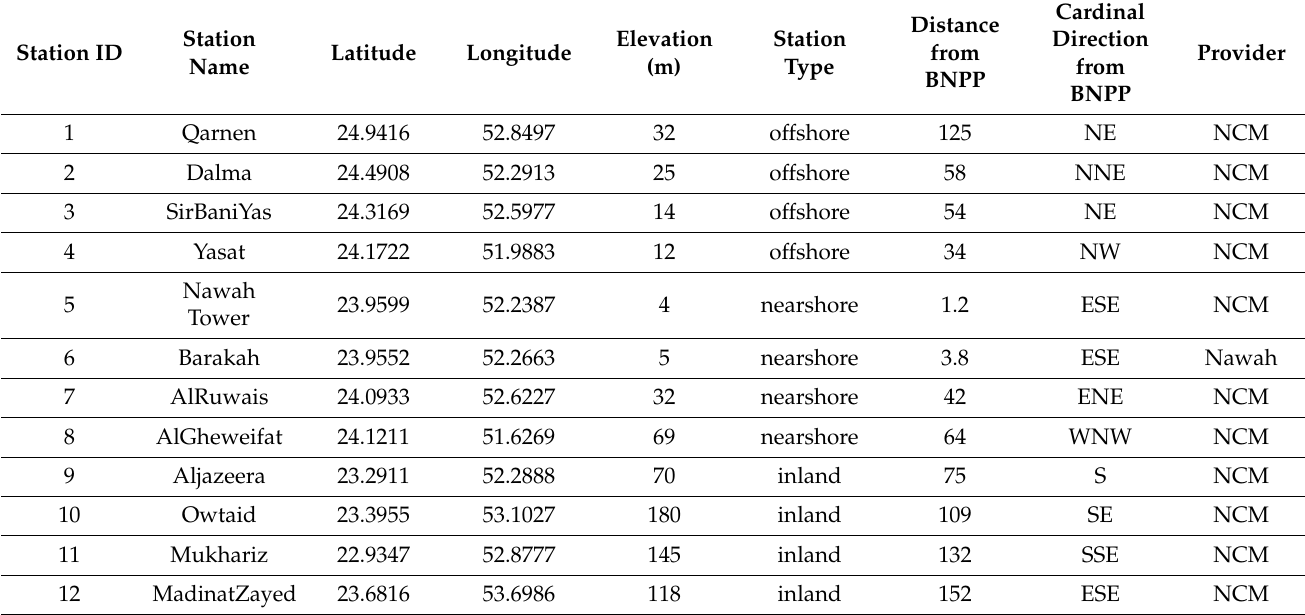
Table 1. List of the weather stations used for the model